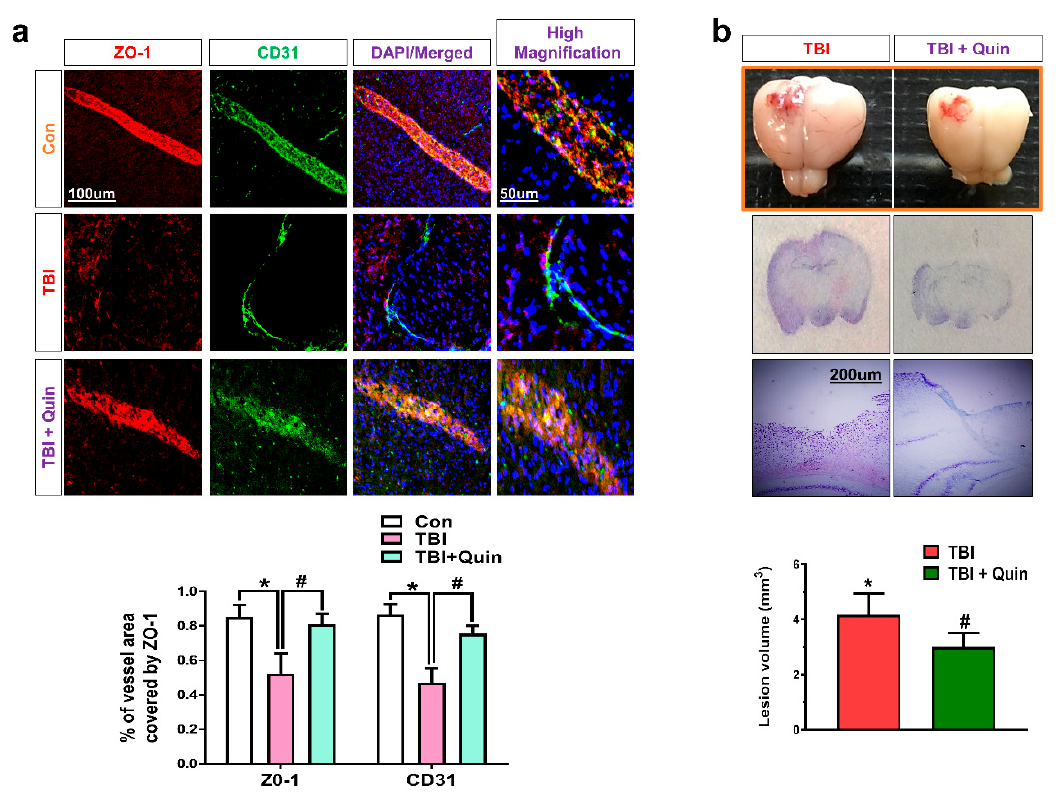
Figure 5. Quinpirole regulates the BBB-associated ZO-1 and CD31 expression levels and lesion volume after brain injury. ( a ) Representative confocal microscopy images for ZO-1 (TRITC-label, red) and CD31 (FITC-label, green) immunofluorescence reactivity in the ipsilateral cortex in injured mouse brain (green, FITC; red, TRITC; blue, DAPI). ( b ) Representative images showing TBI mouse brain after surgery, and Nissl-stained images showing the lesion volume in the brain injury and quinpirole-treated groups, with respective bar graphs, (magnification × 10, n = 6). Data were obtained following three independent experiments. The ImageJ software was used for quantitative analysis of the confocal microscopy images and the percentage of vessels were quantified that containing ZO-1 in the representative field. Values are expressed as mean ± SEM. We performed the one-way ANOVA test followed by post-hoc analysis. A p value < 0.05 was considered statistically significant. * significantly different between the control and brain injury groups, # significantly different between the brain injury and quinpirole-treated groups. ANOVA: analysis of variance, BBB: blood–brain barrier, CD31: cluster of differentiation 31, FITC: fluorescein isothiocyanate, SEM: standard error of mean, TRITC: tetramethylrhodamine-isothiocyanate, ZO-1: zonula occludens-1.